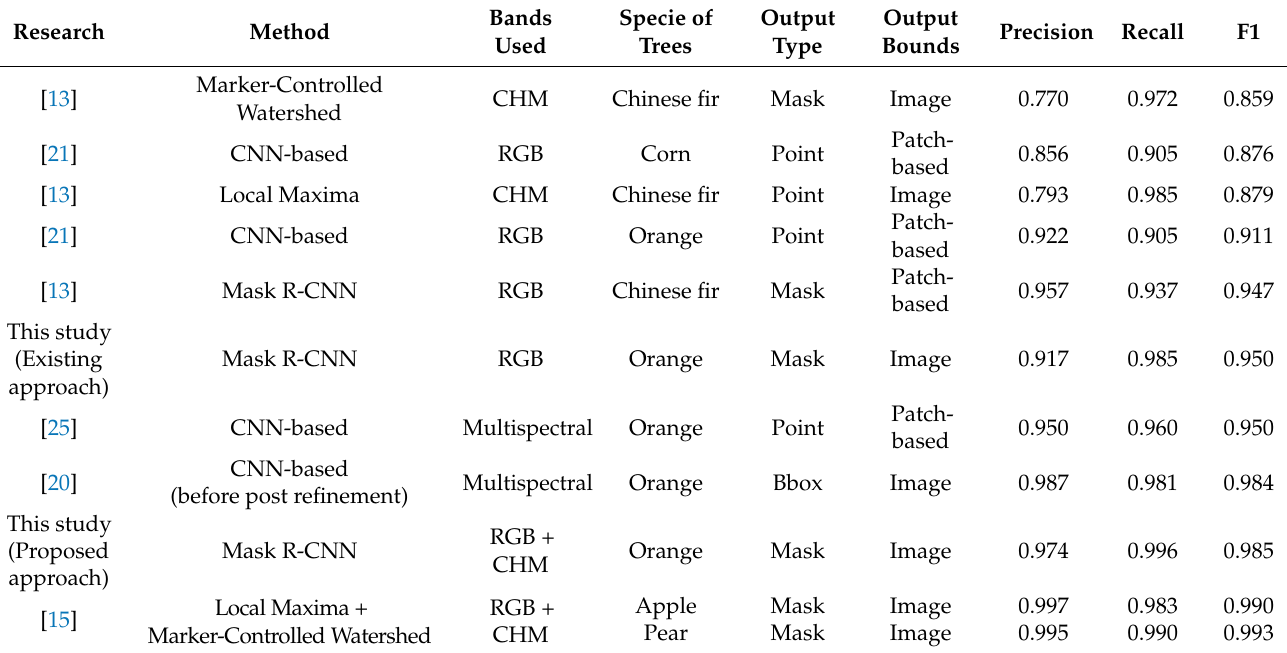
Table 6. Characteristics and results of research similar to this